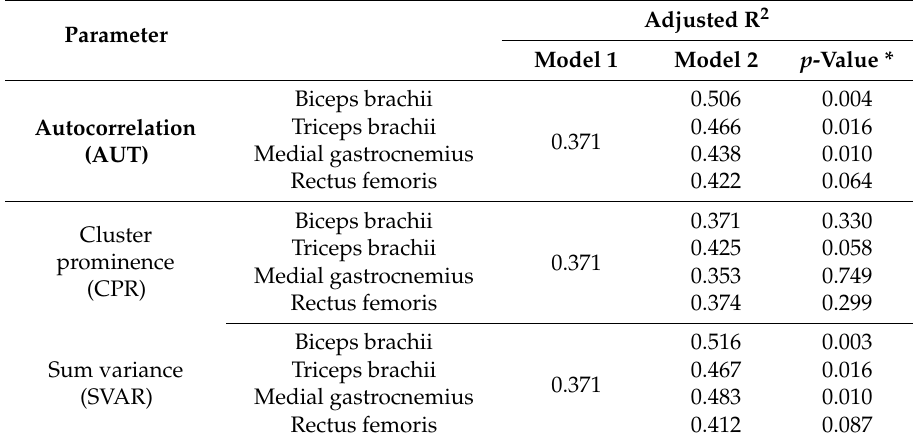
Table 5. The linear regression model to predict the grip